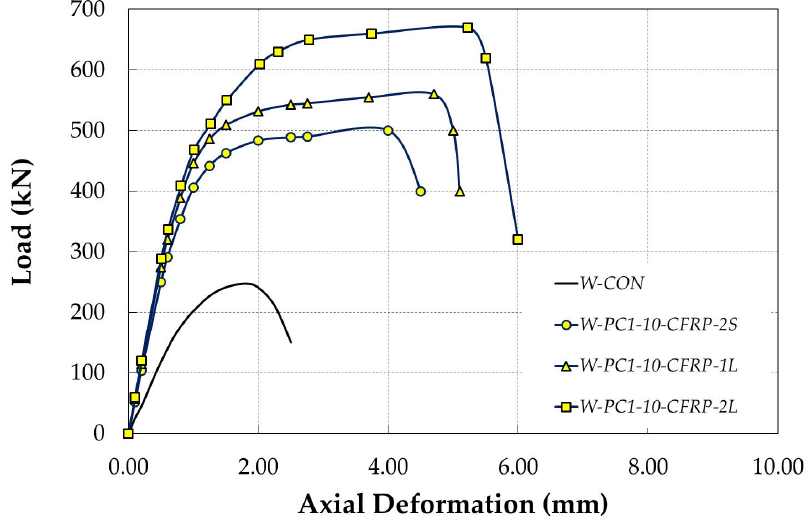
Figure 8. Axial Load versus axial deflection responses (control and CFRP with CS mortar walls).